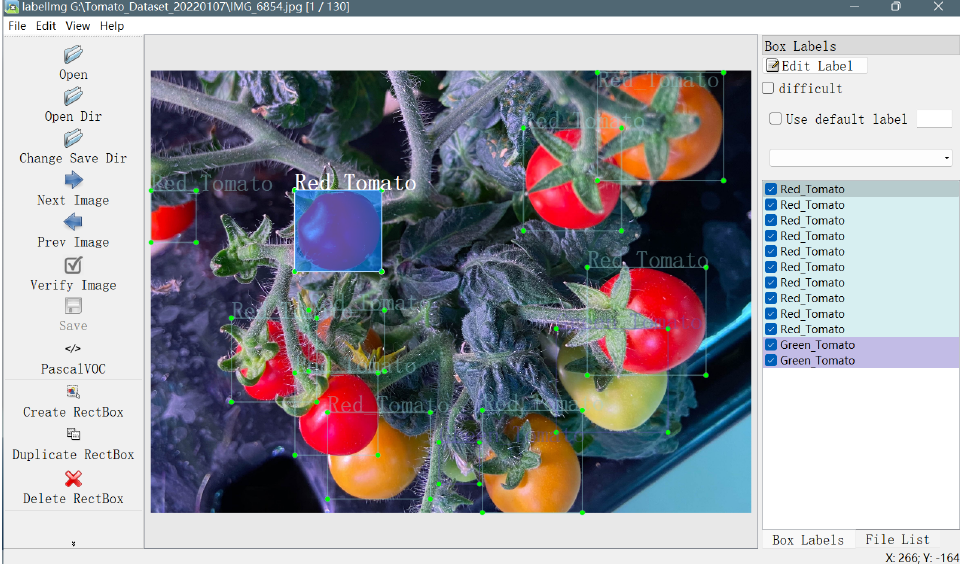
Figure 2. Diagram illustrating dataset annotation using